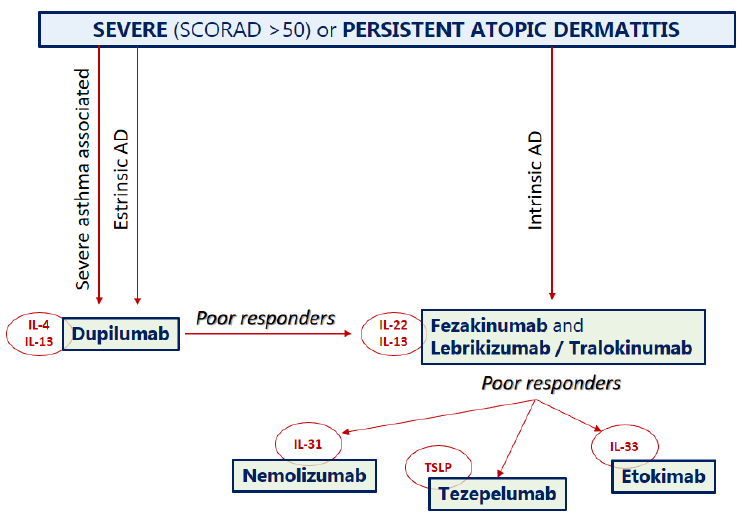
Figure 2. A proposal of a hypothetical therapeutic flow-chart for atopic dermatitis that could be applied as soon as other biologics, in addition to dupilumab, are approved.